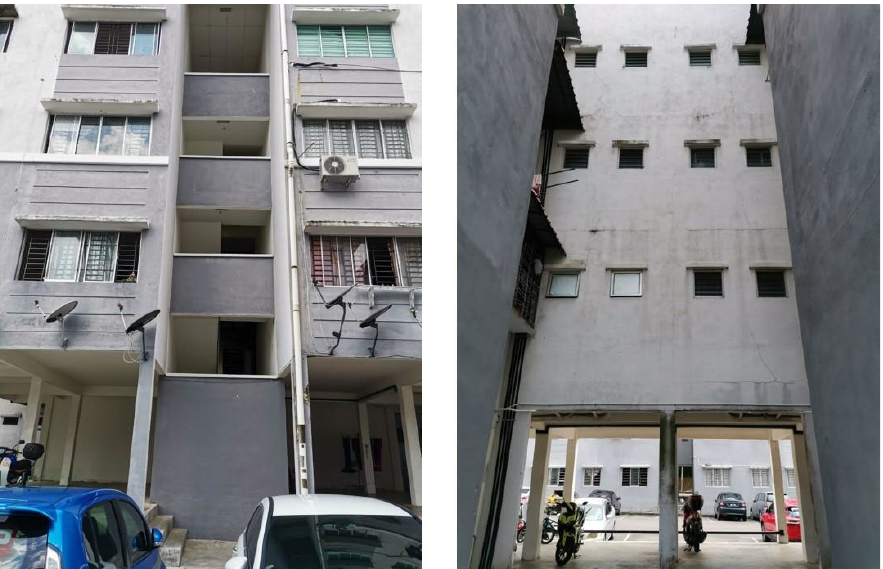
Figure 2. Front and rear façade of the test room. (( left ): front façade of the case study building/inlet window; ( right ): rear façade of the case study building/the washroom exterior façade/outlet win ‐